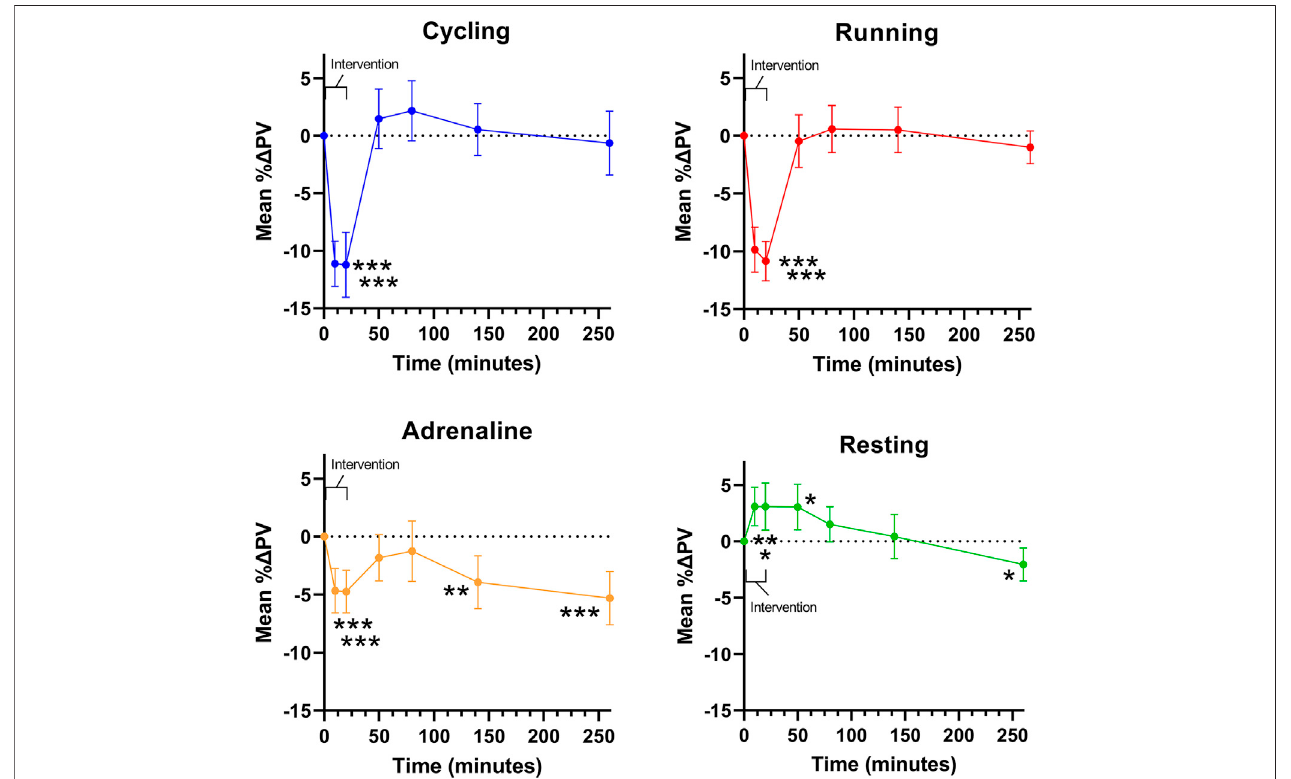
FIGURE 2 | Mean changes in plasma volume (PV) over time during and following interventions. Error bars represent a 95% con fi dence interval.